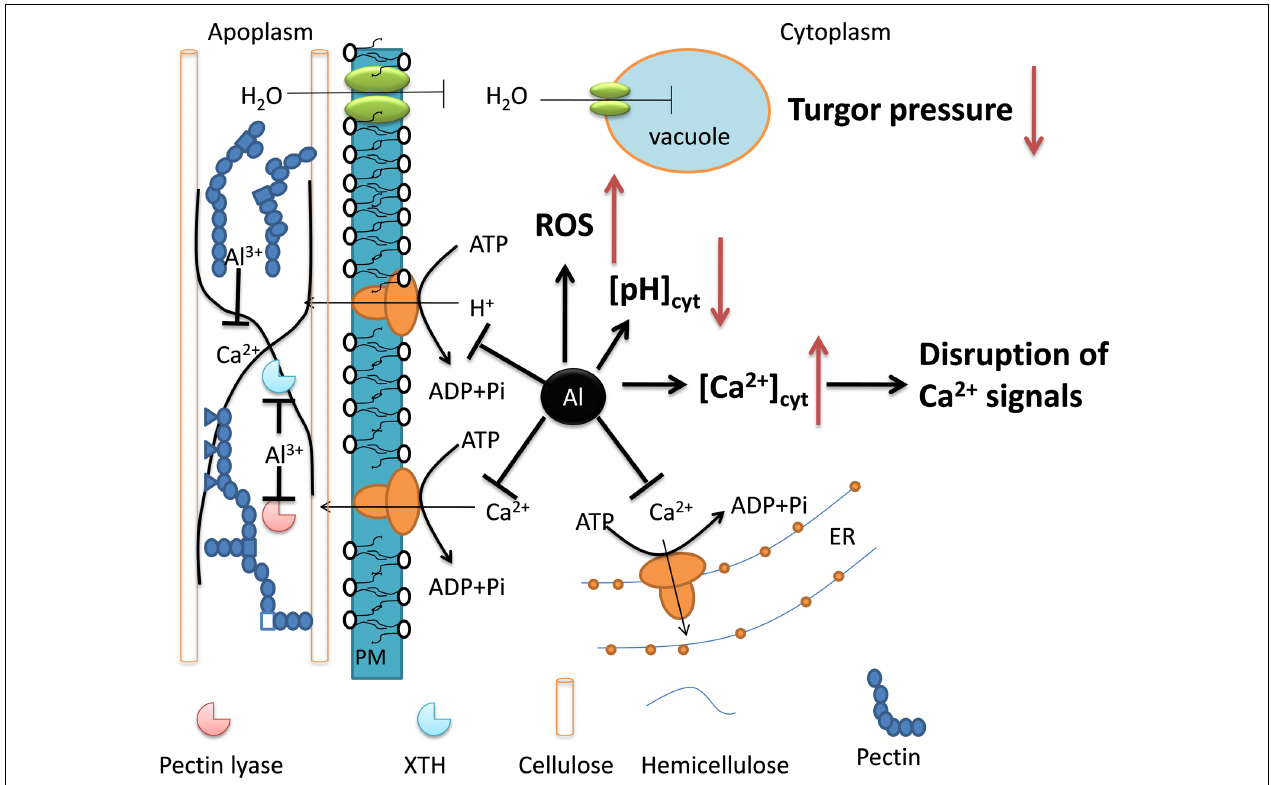
FIGURE 2 | The schematic diagram representing important processes affected by Al stress, which are responsible for Al-induced root growth inhibition. Arrow and bar in black indicate up- and down-regulated changes, respectively, while up- and down-arrow show putatively increased and decreased biochemical and physiological changes,